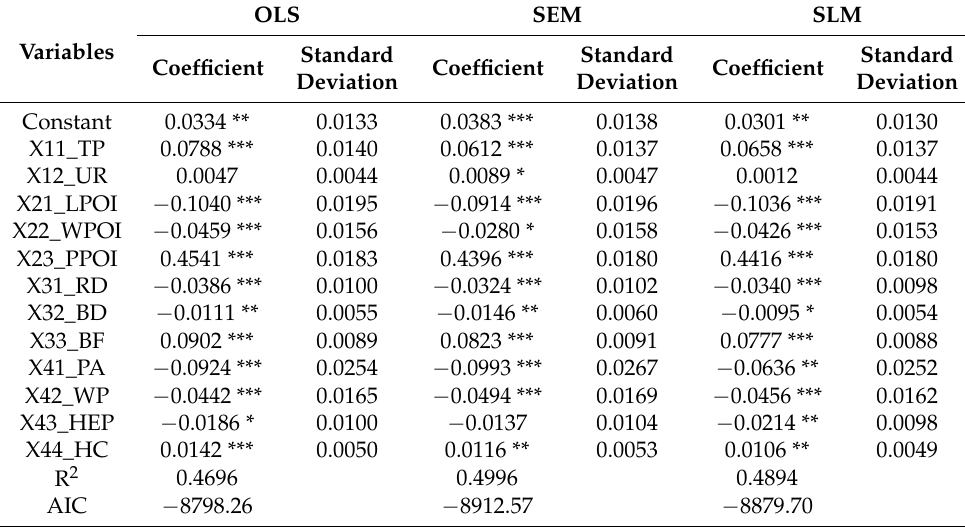
Table 3. Results of spatial spillover effects for the OLS model, SEM, and SLM. OLS SEM SLM Variables Standard Standard Standard Coefficient Coefficient Coefficient Deviation Deviation Deviation Constant 0.0334 ** 0.0133 0.0383 ***